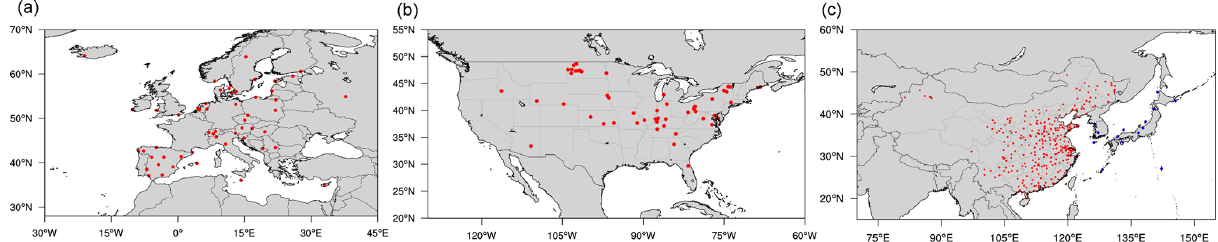
Figure 1. Locations of monitoring sites from various measurement networks in (a) Europe (EU; EMEP), (b) USA (EPA), and (c) East Asia (EA; red points for CNEMC and blue points for EANET).